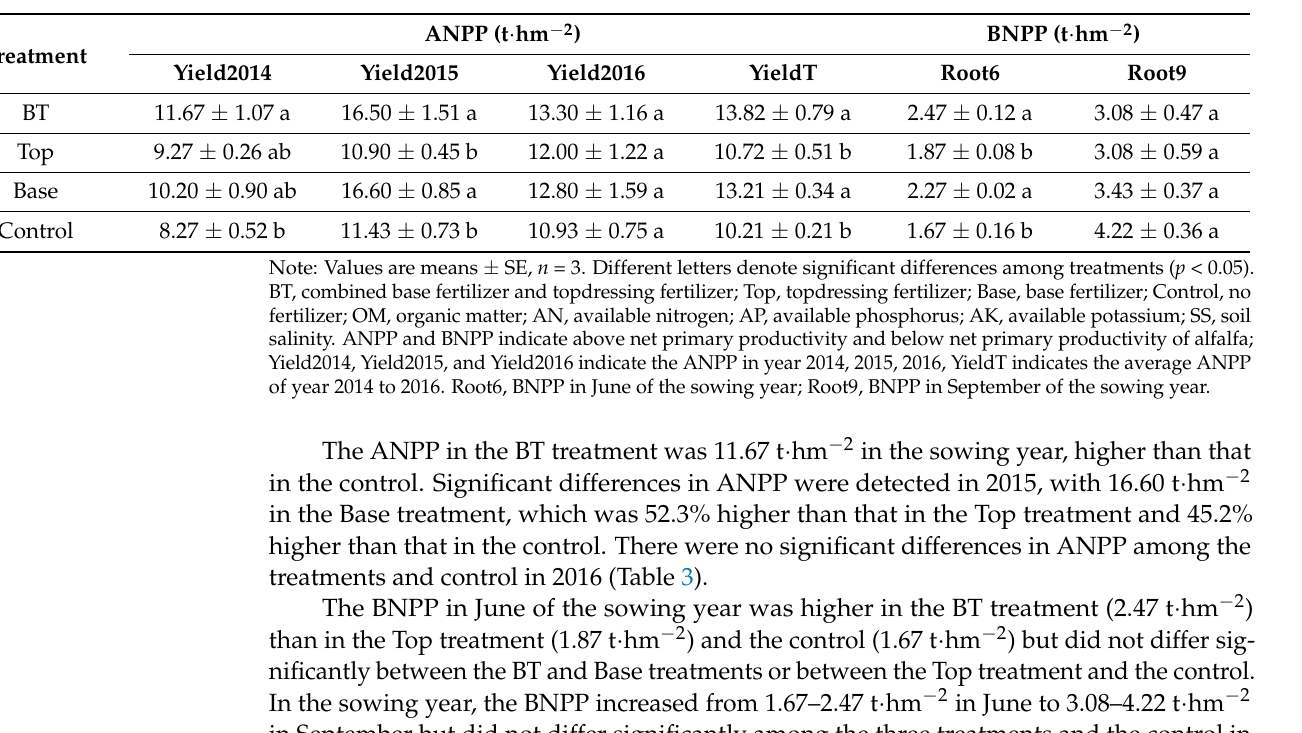
Table 3. Above-ground net primary production and below-ground net primary production in different treatments and the control from 2014 to 2016.